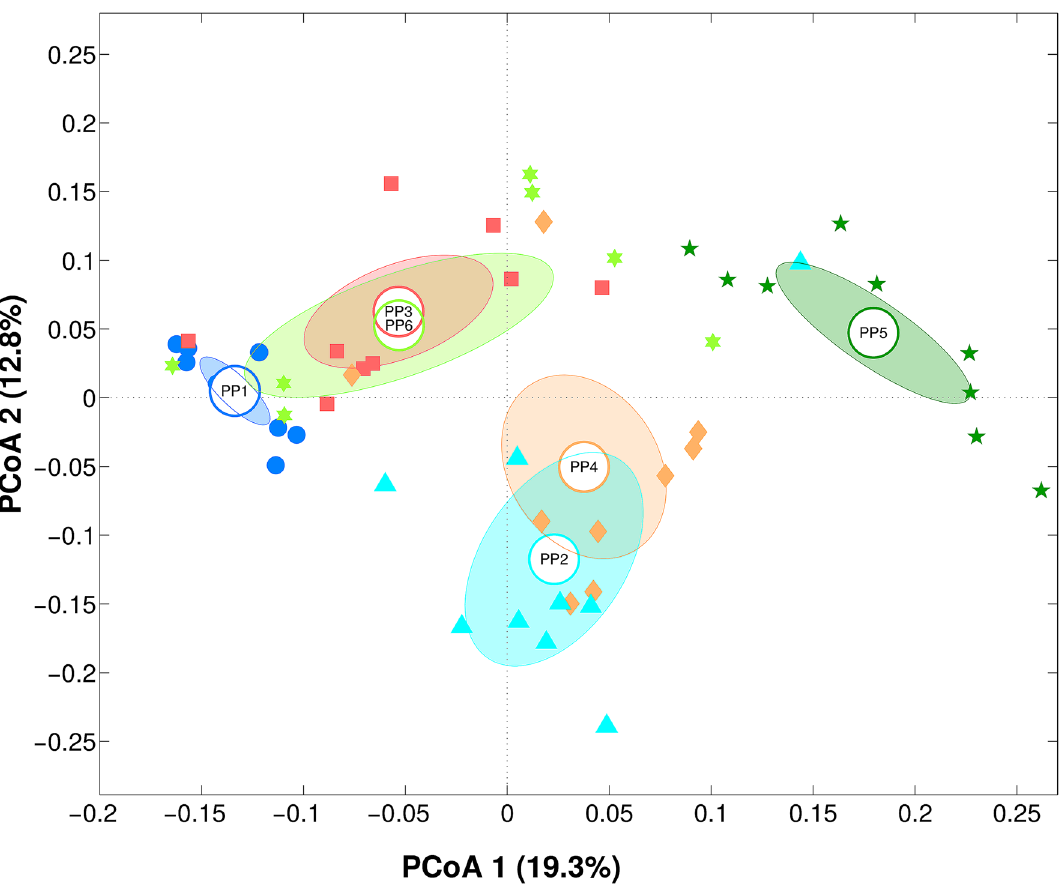
Figure 1. Principal Coordinate Analysis (PCoA) on unweighted Unifrac distances among samples grouped per Pasture area-Producer. Each dot represents a sample, the centroid represents its average value, and the ellipse the mean standard error (SEM) based data confidence. The first and second principal component is